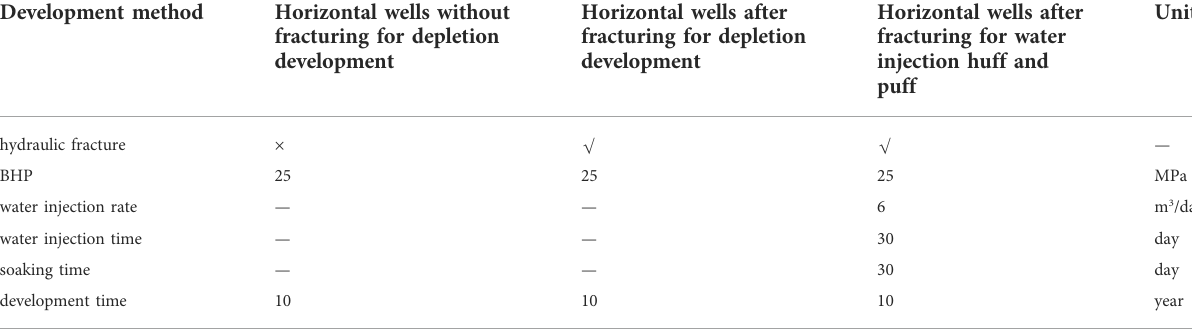
TABLE 2 Speci fi c parameters for different development